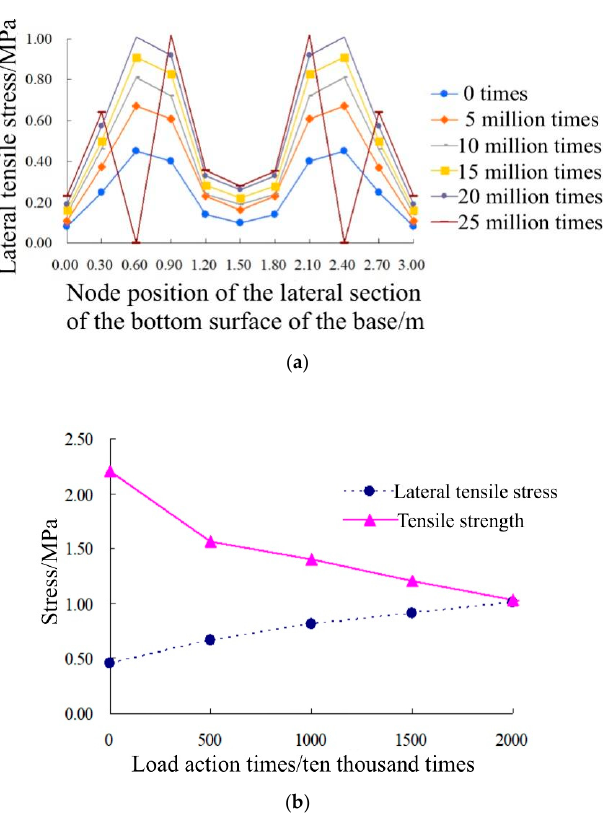
Figure 19. Lateral mechanical characteristics of base plate under fatigue load (working condition 1). ( a ) Maximum stress development diagram of the bottom surface at the mid-span position; ( b ) number of cracks at the maximum tension stress.